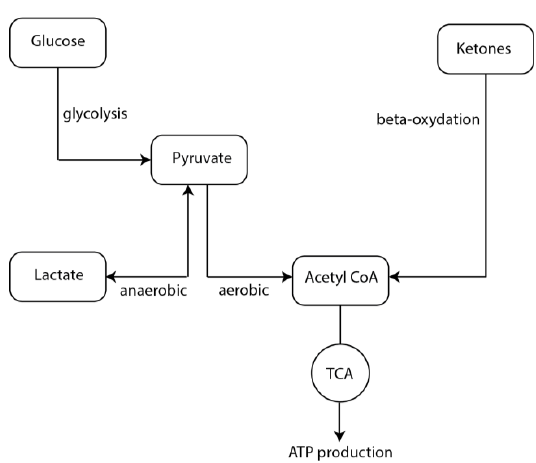
Figure 1. Schematic representation of the metabolic pathways followed by glucose and ketones.